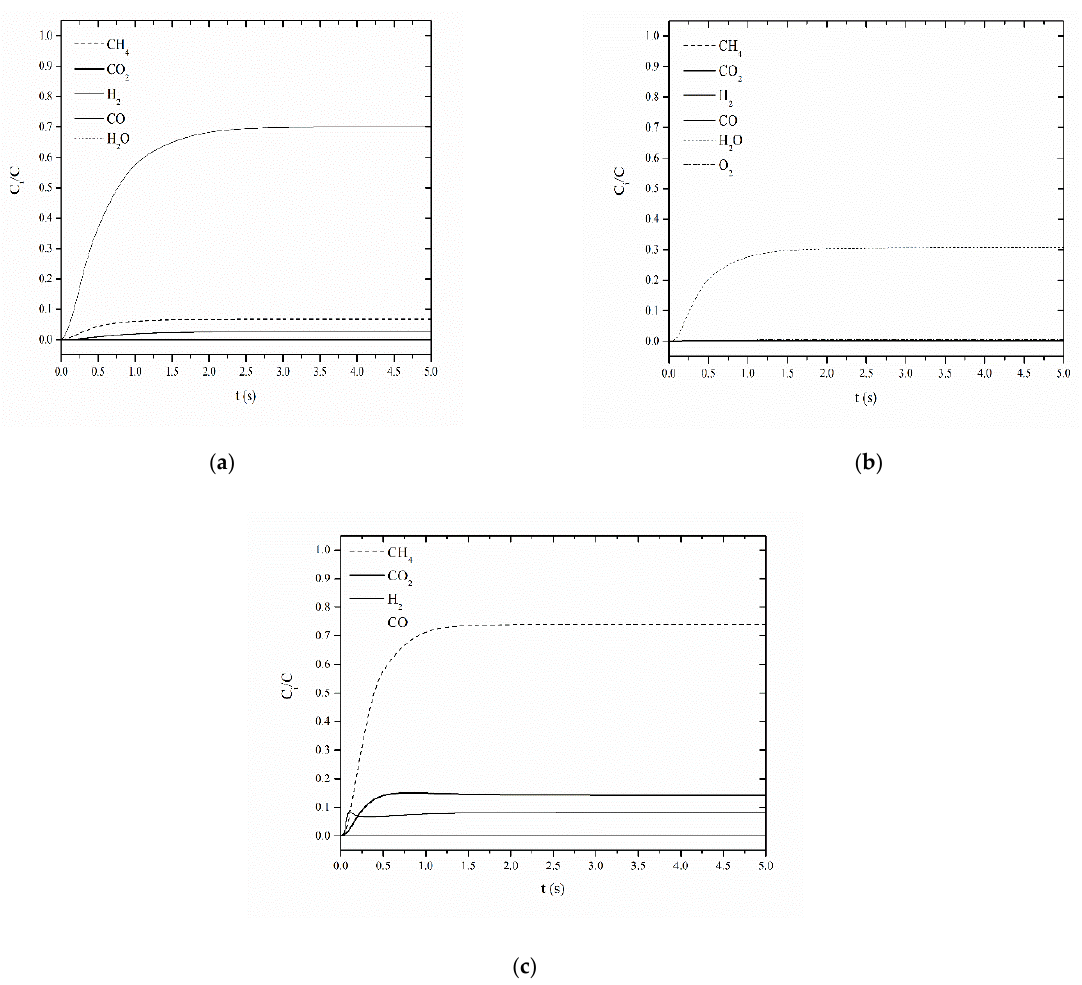
Figure 2. Alternative methane reform processes. Evolution of concentrations. ( a ) DRM, ( b ) ATRM, ( c ) CRM. Conditions: Cat. Ni (4.82 wt.%)/ γ -Al 2 O 3 , 1023 K, 1.0 bar.